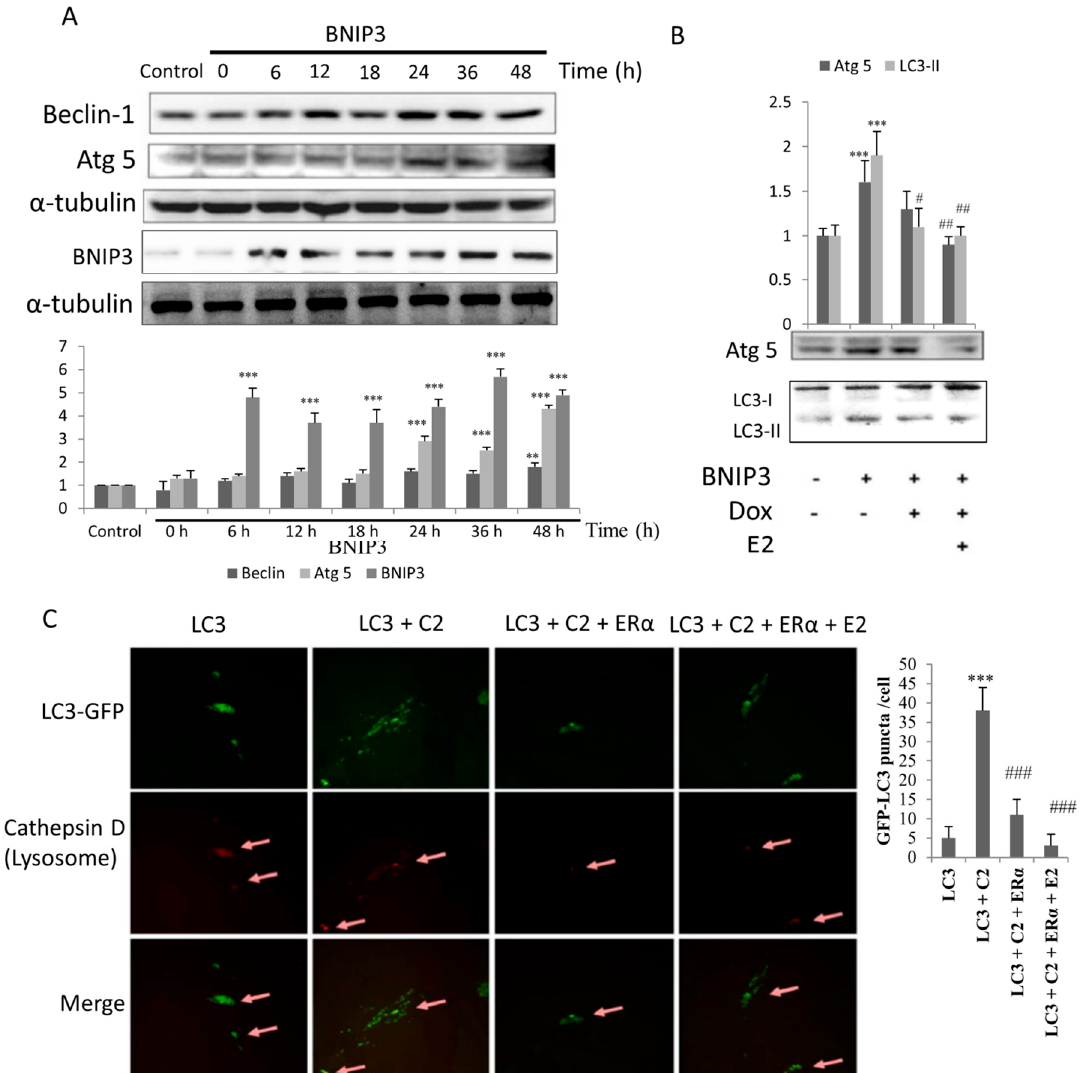
Figure 3. ER α /E2 blocked the BNIP3-induced autophagy effect. H9c2 cells were transfected with BNIP3 (6 μ g) and collected at indicated times for Western blot assay. ( A ) The levels of Beclin-1 and Atg 5 increased in proportion to the level of BNIP3 expression. n = 5, ** p < 0.01 and *** p < 0.001 show significant differences with respect to control cells; ( B ) Tet-on ER α H9c2 cells were transfected with BNIP3 (6 μ g), incubated for 6 h, and then exposed to doxycycline (1 μ g/mL) for 1 h. Cells were then exposed to E2 (10 nM) in serum-free medium for 18 h. Western blot assay was used to detect the levels of proteins involved in the autophagic (Atg5, LC3-I1/LC3-I) pathways. Doxycycline and/or E2 treatment resulted in attenuation of autophagy. n = 5, ** p < 0.01 and *** p < 0.001 show significant differences with respect to the control; # p < 0.05 and ## p < 0.01 show significant differences with respect to the BNIP3 group; ( C ) H9c2 cells were transfected with LC3-GFP and/or ER α plasmids and incubated for 6 h, followed by incubation with E2 and/or C2 for 18 h in growth medium. Cells were fixed, incubated with primary anti-cathepsin D antibody (rabbit), and then incubated with secondary anti-rabbit IgG (red). Green fluorescence represents the expression of LC3, and the puncta of green fluorescence represent the active form of LC3 (LC3-II), indicated the formation of autophagosome. Expression of cathepsin D, a lysosome indicator, indicated the location of lysomomes (arrow heads). The merged panels indicate co-localization of autophagosomes and lysosomes (arrow heads). E2: 17 β -estrodiol, C2: C2 Ceramide ( N -Acetyl- D -erythro-Sphingosine, BNIP3 inducer). n = 3, *** p < 0.001 shows a significant difference with respect to the control LC3 transfected cells group; ### p < 0.001 shows a significant difference with respect to the control LC3 + C2 group.